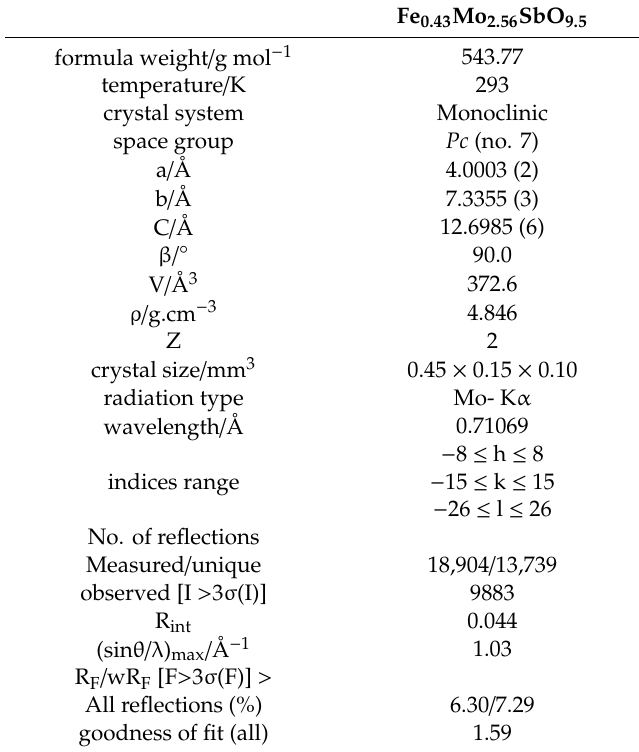
Table 1. Crystallographic data for Fe 0.43 Mo 2.56 SbO 9.5